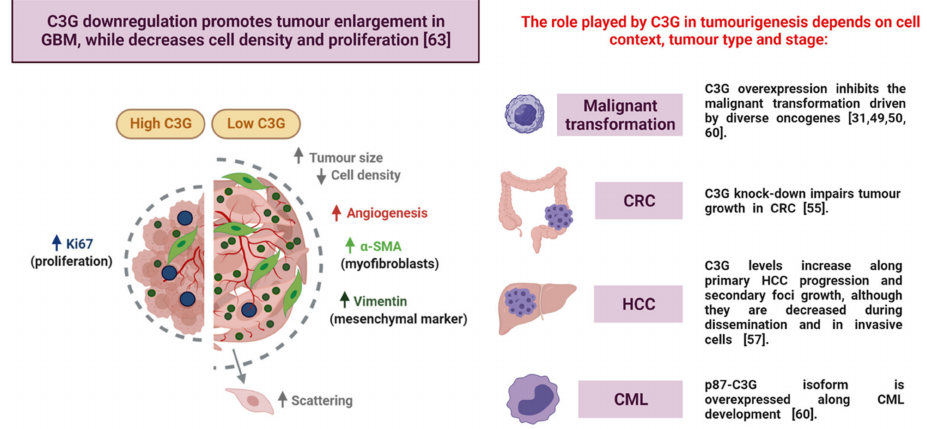
Figure 4. Role played by C3G in GBM tumour growth compared to other tumourigenic pro- cesses. In GBM, C3G knock-down increases the number of foci, cell scattering, tumour size, stroma infiltration, and angiogenesis, while decreases cell density, proliferation, and the number of tu- mour cells within the tumour (left panel). This differs from its actions in other tumours (right panel) [31,49,50,55,57,60]. GBM: glioblastoma; α -SMA: α -smooth muscle actin; CRC: colorectal carcinoma; HCC: hepatocellular carcinoma; CML: chronic myeloid